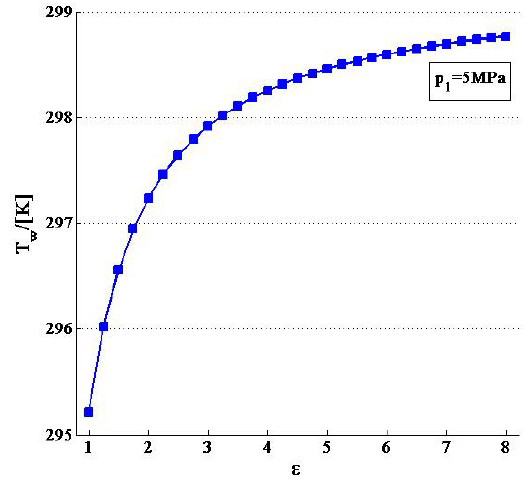
Figure 4. Water temperature various with water air volume ratios.